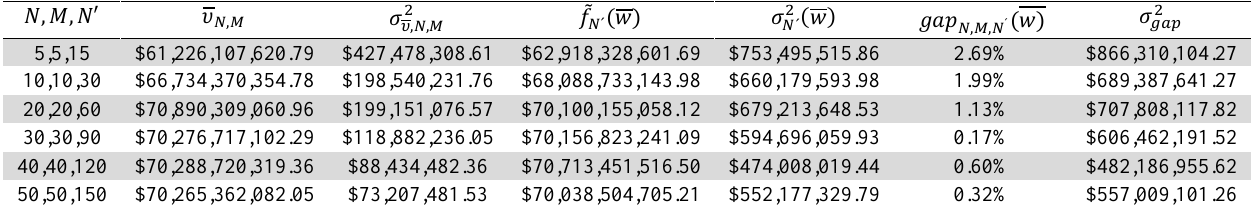
Result Report by SAA procedure